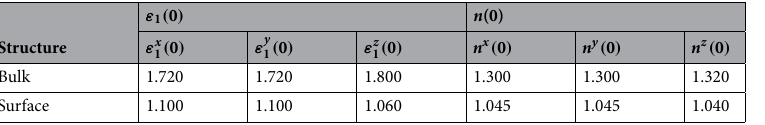
Table 3. Static real part of dielectric function ε 1 ( 0 ) and static refractive index n (0) of orthorhombic bulk and surface of CsPbBr 3